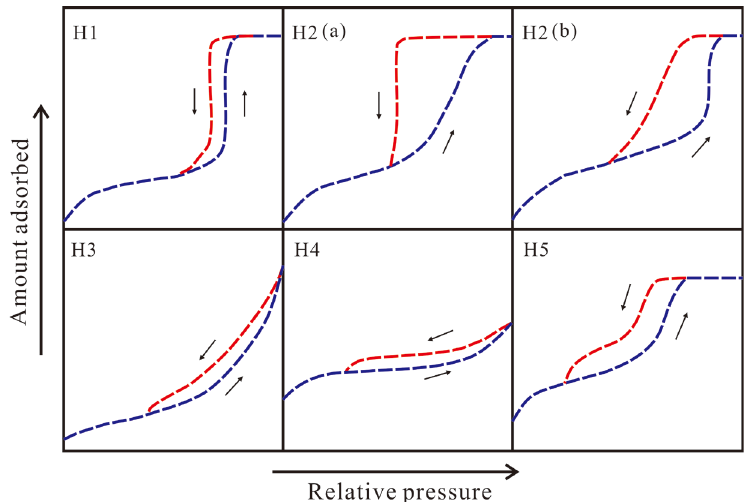
Figure 7. IUPAC hysteresis loop morphological classification [28].